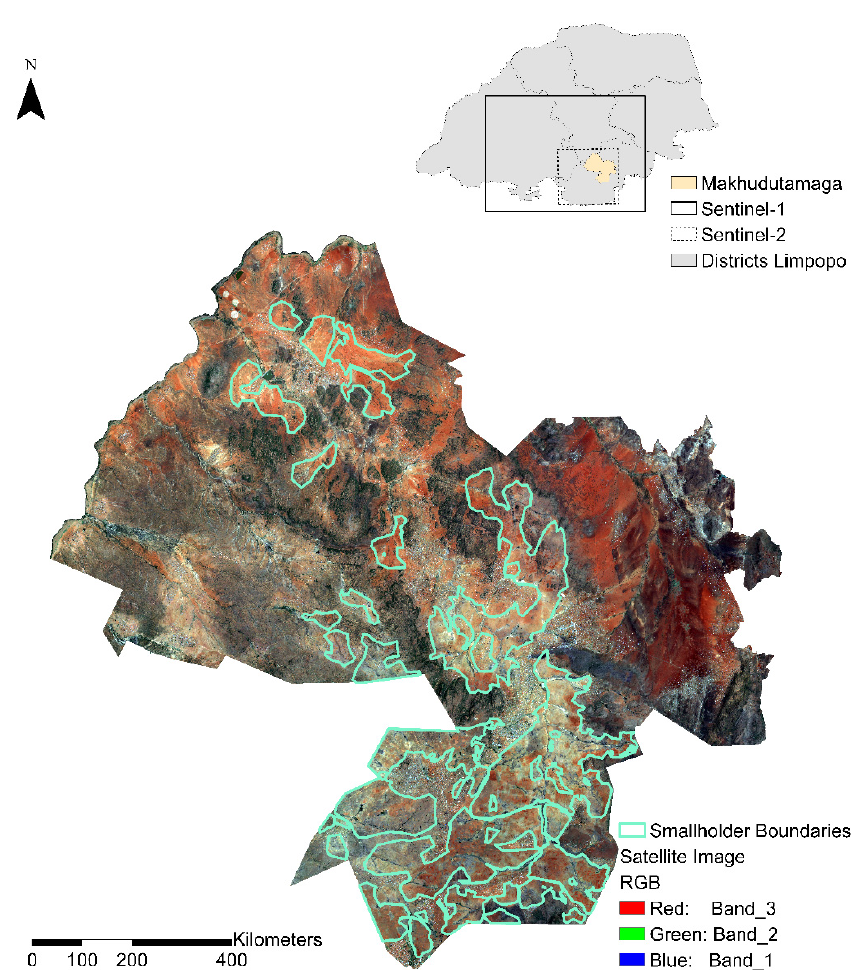
Figure 1. Study area location map for Makhuduthamaga in Limpopo, South